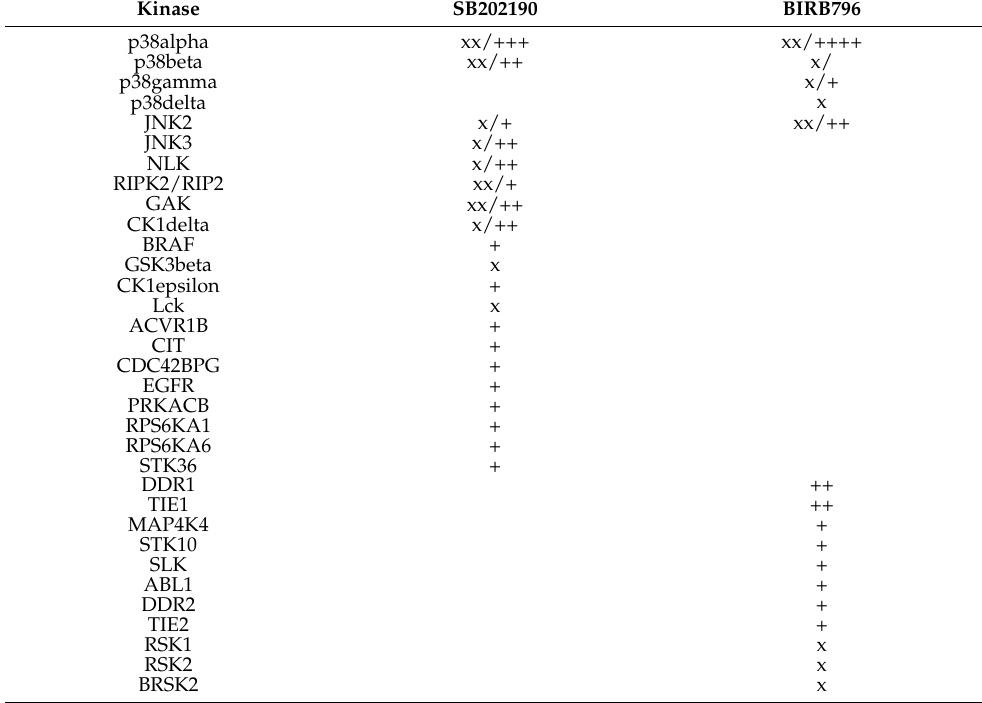
Table 1. Targets and off-targets of SB202190 and BIRB796. Plus signs mark K d nM values from ref. 46: + <1000, ++ <100, +++ <10, ++++ <1. Crosses mark residual kinase activity in the presence of 1 µ M inhibitor (from ref. 47, x <50%, xx